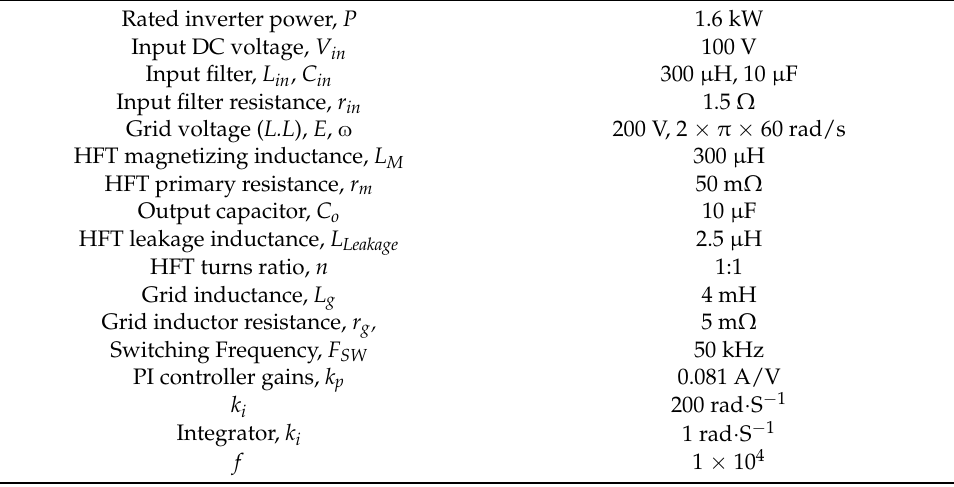
Table 3. IFBI simulation and experimental parameters